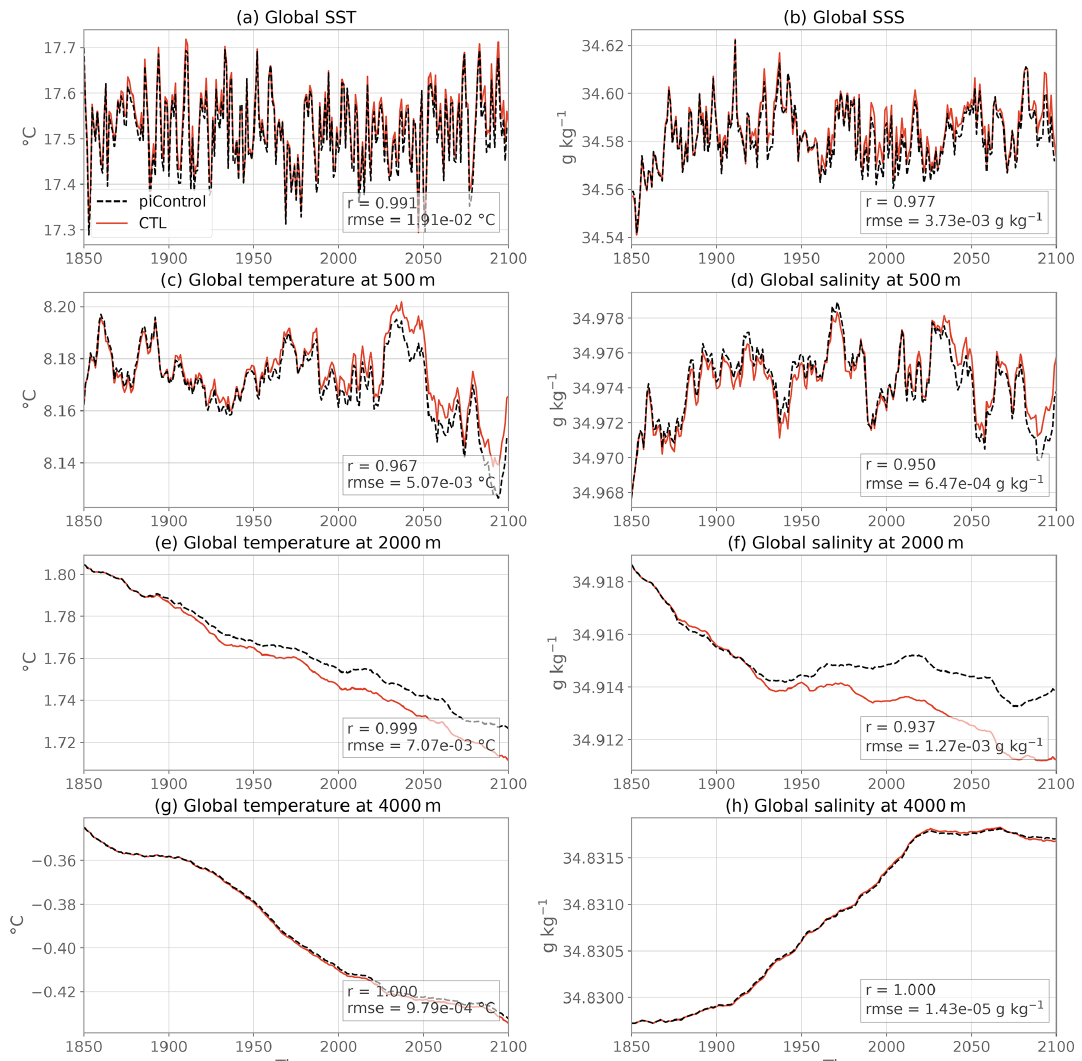
Figure 6. As in Fig. 5 but for global mean temperature and salinity at different vertical